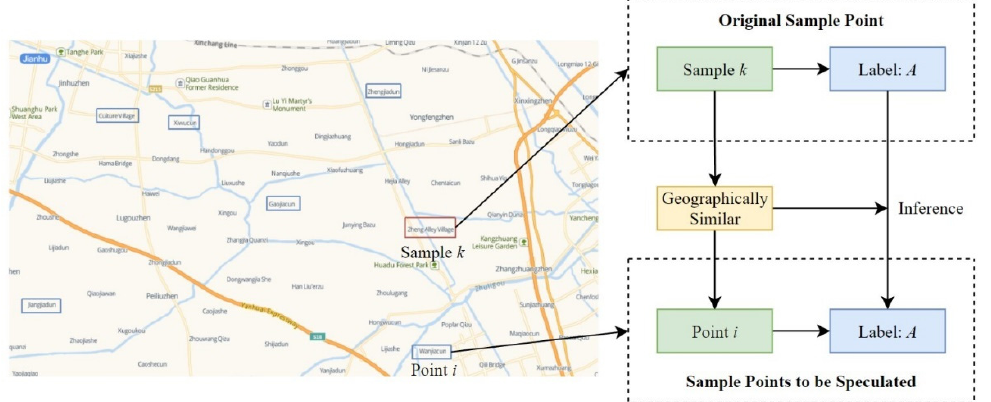
Figure 3. Framework of sample point generation.